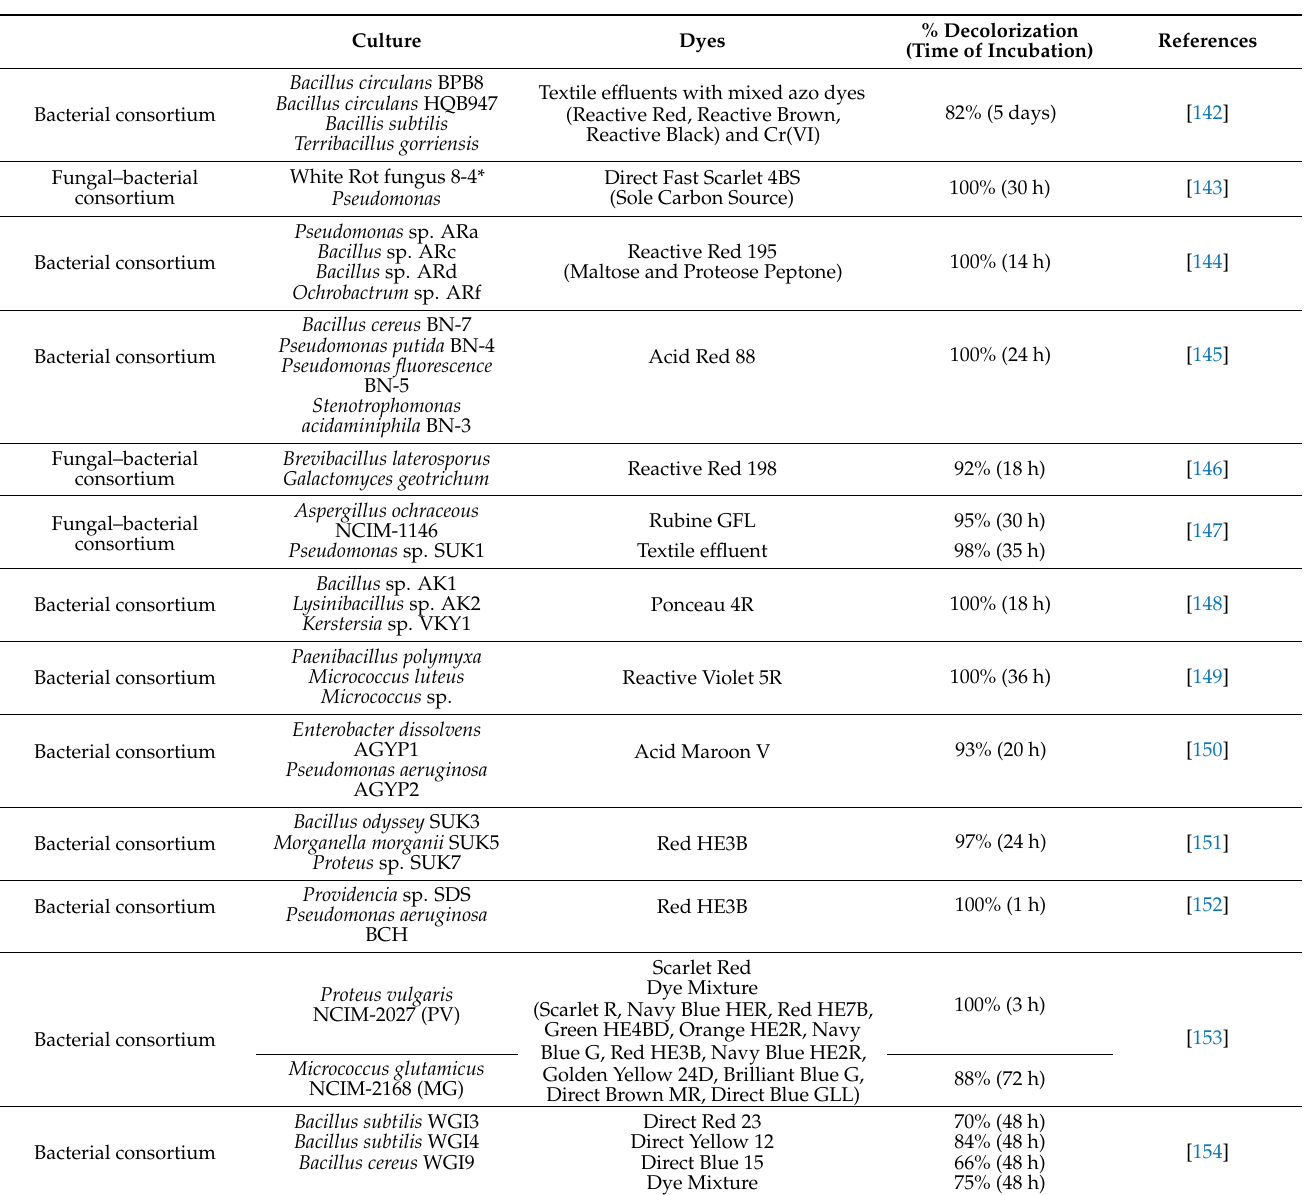
Table 3. List of microbial consortia used in different dye decolorization